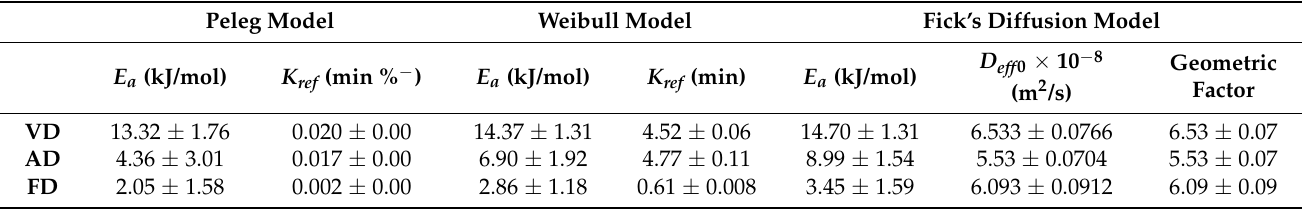
Table 1. Parameter estimates (parameter ± standard error) of activation energy ( E a , kJ/mol), K ref (min % − and min for Peleg and Weibull, respectively), effective diffusivity ( D eff 0 , m 2 /s) and the estimated geometric